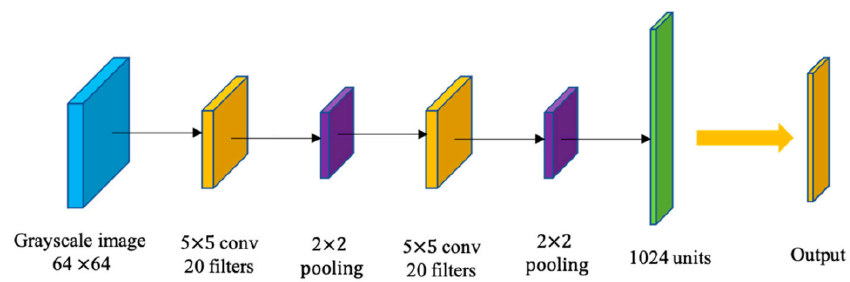
Figure 3. Architecture of the CNN predicting the projections of the control